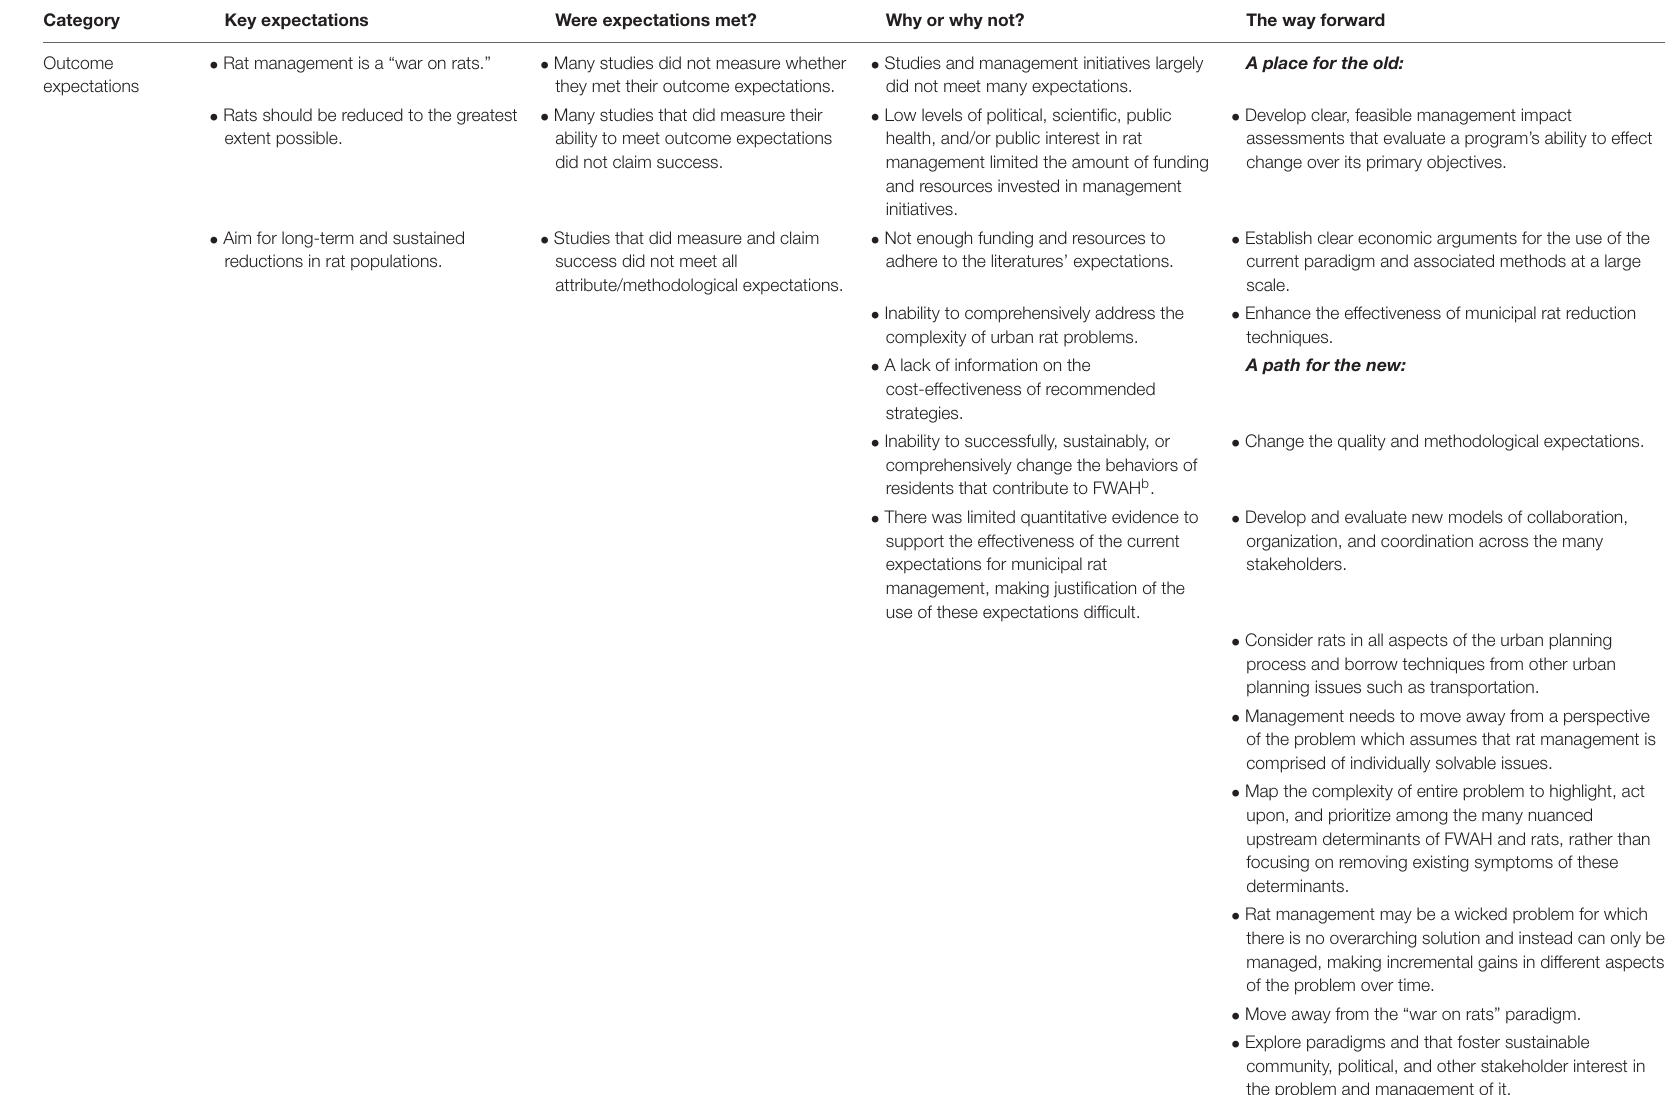
TABLE 2 | Key findings and recommendations of this literature